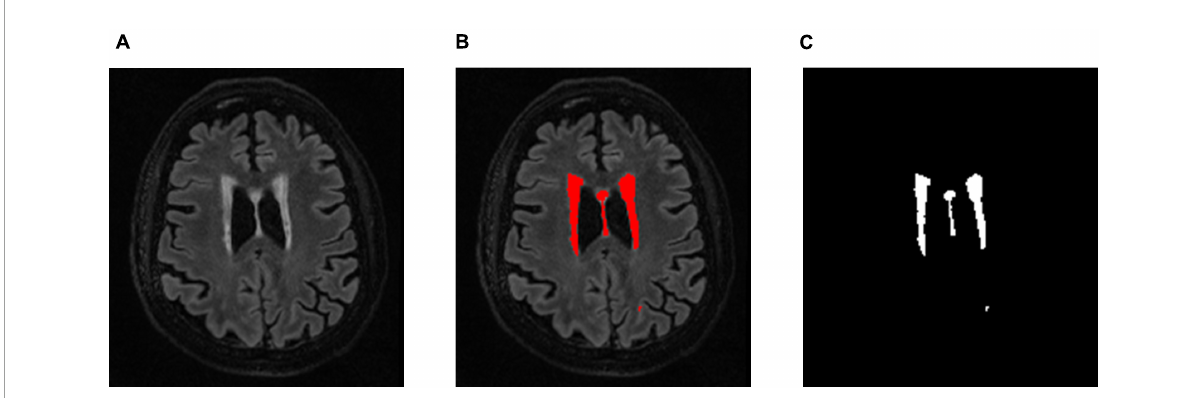
FIGURE1 (A) An example a slice of T 2 FLAIR image volume from one subject showing multiple white matter hyperintensity (WMH) lesions; (B) the results of WMH segmentation using the lesion prediction algorithm (LPA) showing in red, and (C) a WMH binary mask after tissue segmentation, which was used to form the 3D structure of WMH for feature